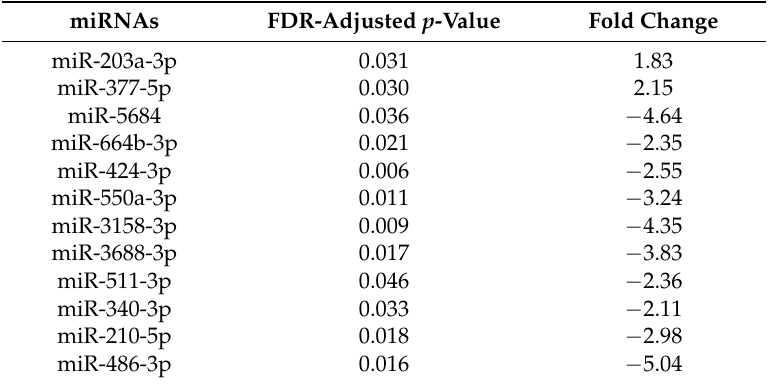
Table 1. List of microRNAs (miRNAs) significantly up-regulated and down-regulated in the BAV group.